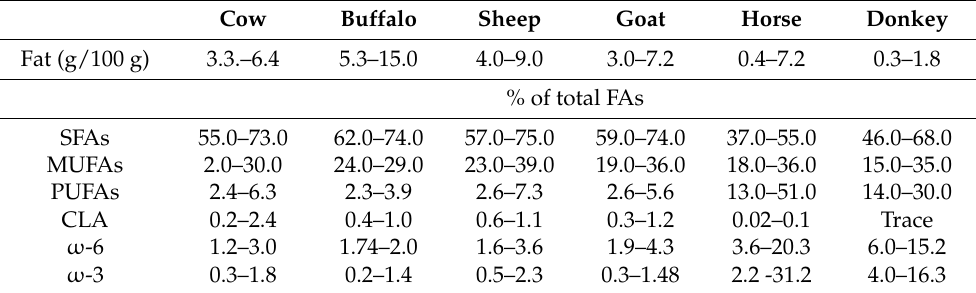
Table 1. Milk fat and fatty acid profiles in ruminant and non-ruminant species (data from [37–42]). Cow Buffalo Sheep Goat Horse Donkey Fat (g/100